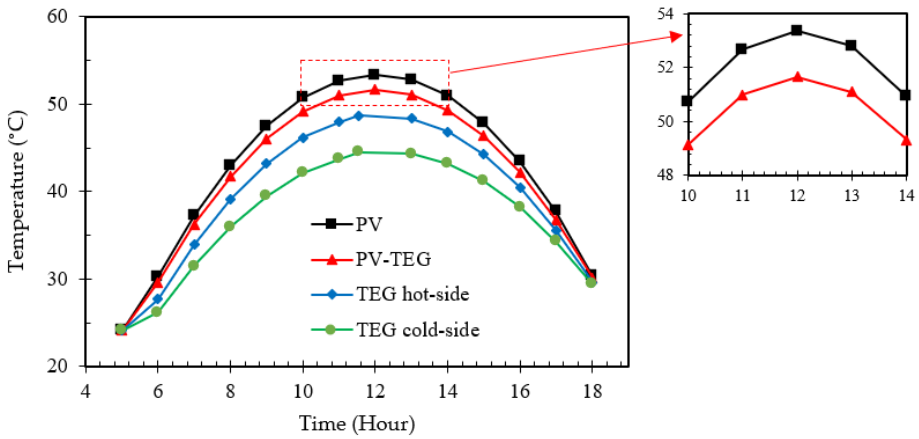
Figure 10. The temperature on the surface of the PV, PV-TEG, and TEG hot and cold